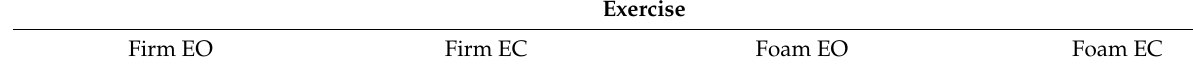
Table A1. Bar plots of IMU-based kinematic features pre- and post-training with and without vibrotactile SA. Error bars on the bar plots indicate SEM values. None of the features showed statistically significant changes for either block of training ( p > 0.05).